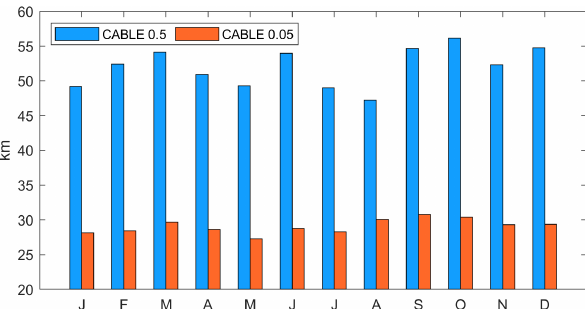
Figure 6. Monthly average spatial resolutions (correlation lengths) of the TWS estimates derived from CABLE 0.5 ◦ and CABLE 0.05 ◦ in Australia between 1981 and